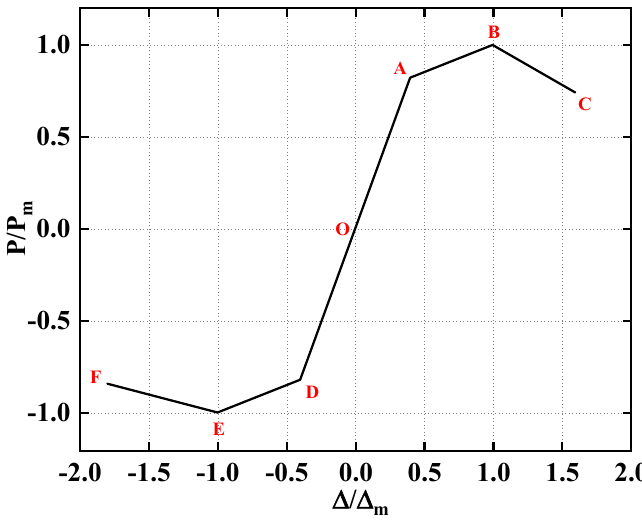
Figure 12. Skeleton curve model.